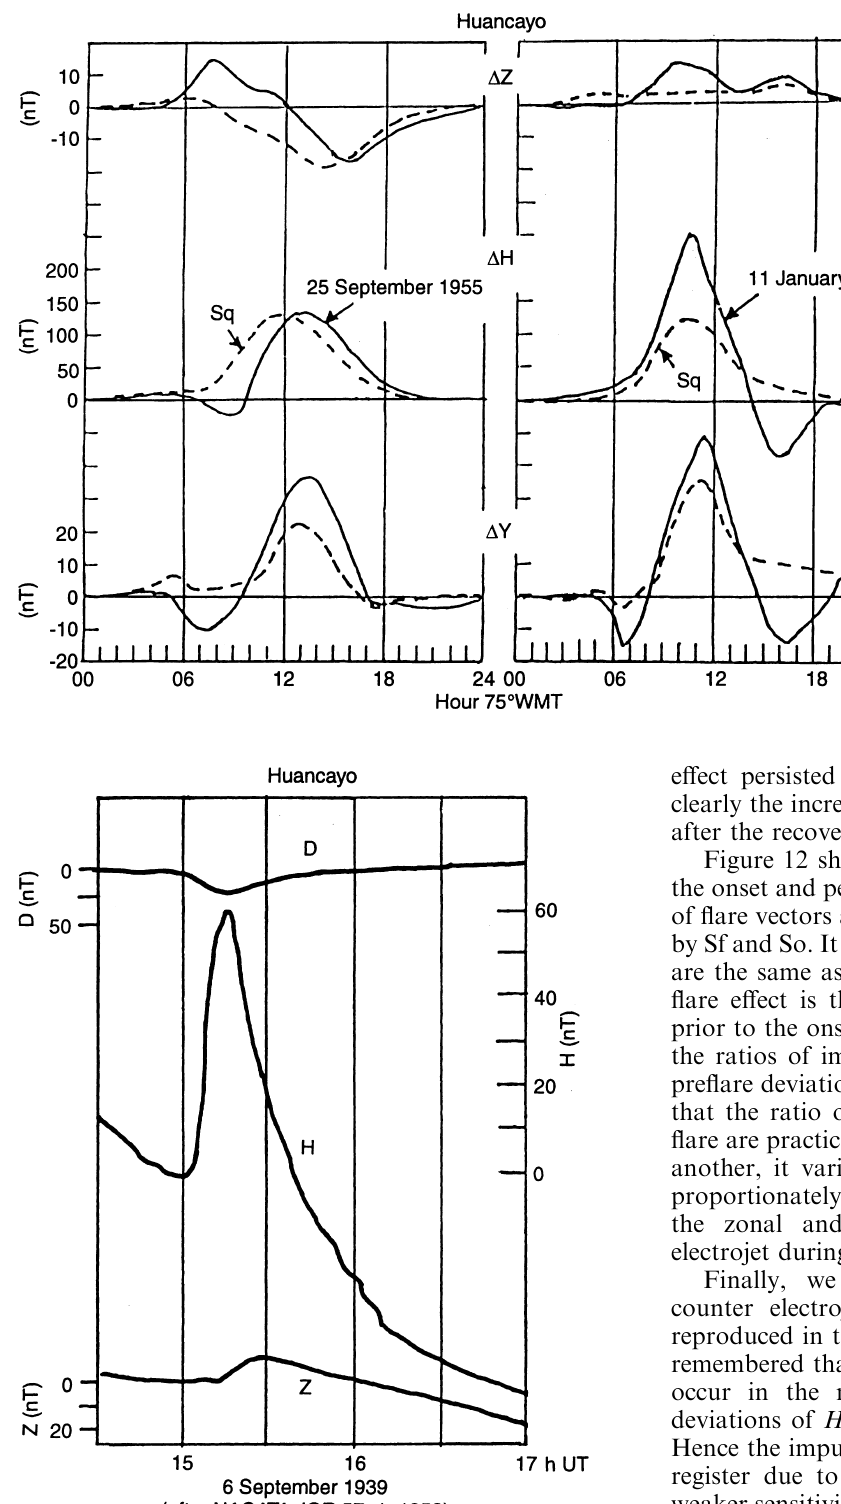
Fig. 7. Reproduction of magnetogram at Huancayo during the solar flare on September 6, 1939 (after Nagata,